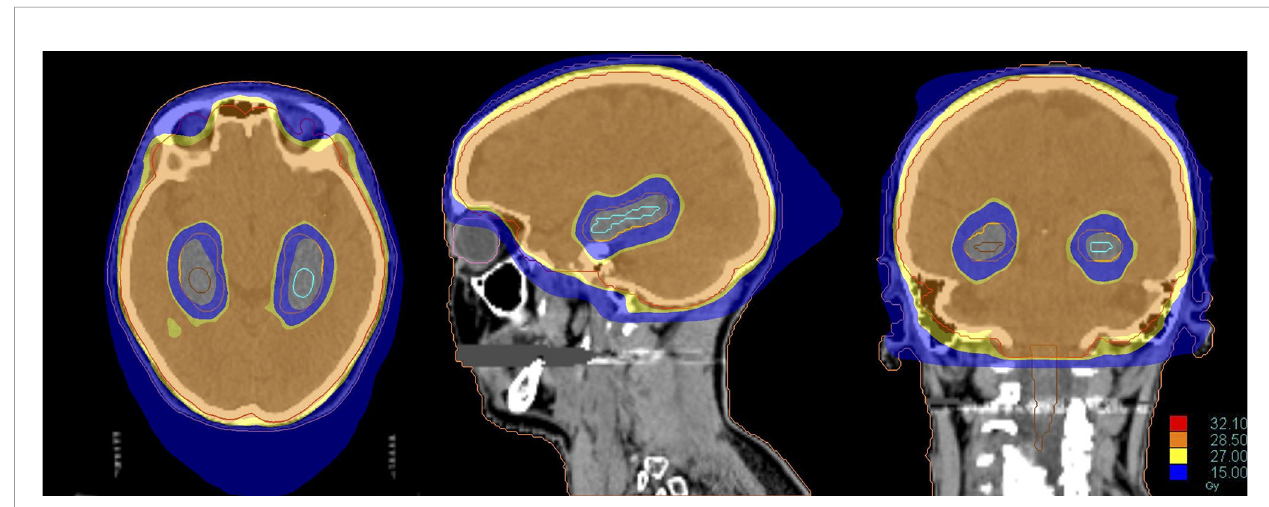
FIGURE 4 | Dose distribution of a Hippocampal Avoidance WBRT (HA-WBRT) in Helical Tomotherapy. The prescription dose was 30 Gy/10 fx with hippocampal sparing (outlined on the right in brown and on the left in light blue, with an expansion margin of 5 mm corresponding to the